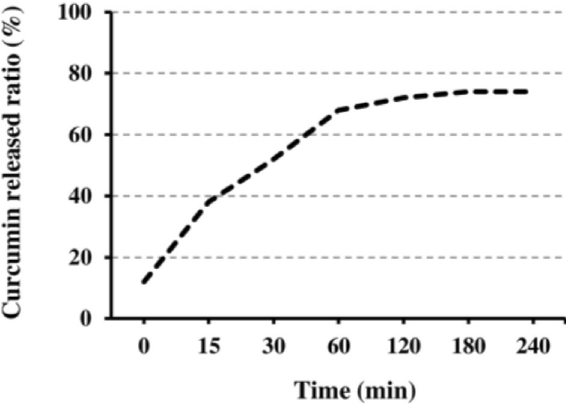
Figure 2. Profile of Cur release from